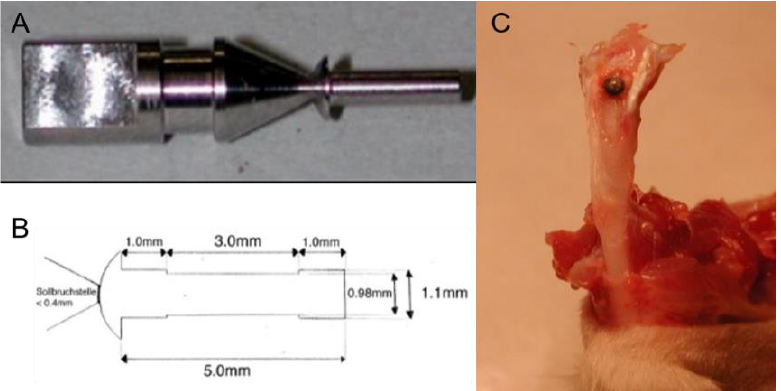
Figure 1. ( A ) Graph depicting the holder and cap of the mini-pin implant, ( B ) the design of the mini-pin implant, and ( C ) the implantation of the mini-pin implant.